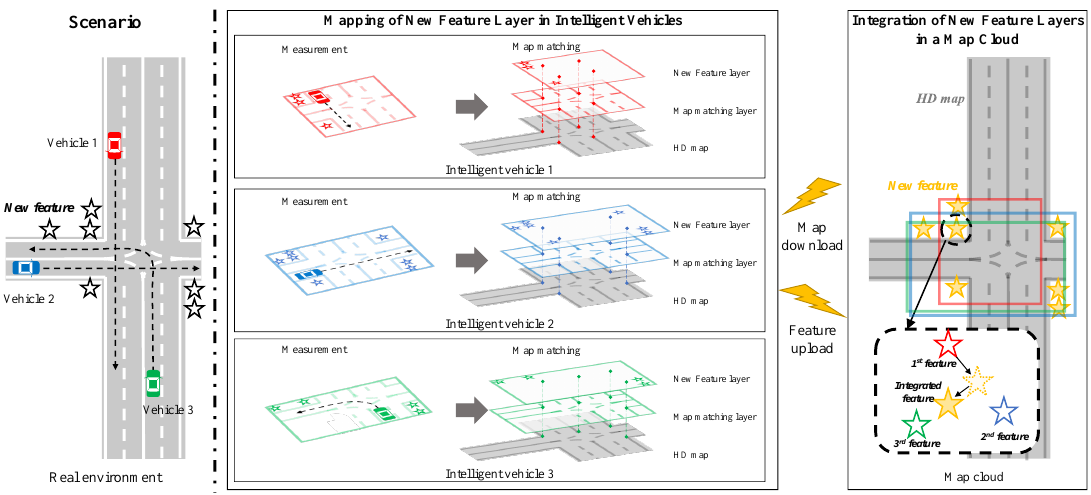
Figure 1. The crowd-sourced mapping process of the new feature layer with a map cloud system.